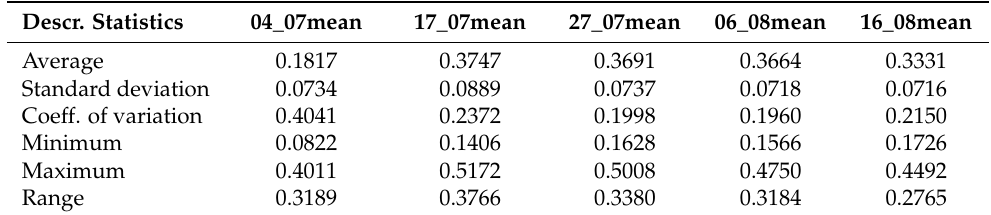
Table 8. The descriptive statistics of the SAVI mean values across all pilot fields during each data collection